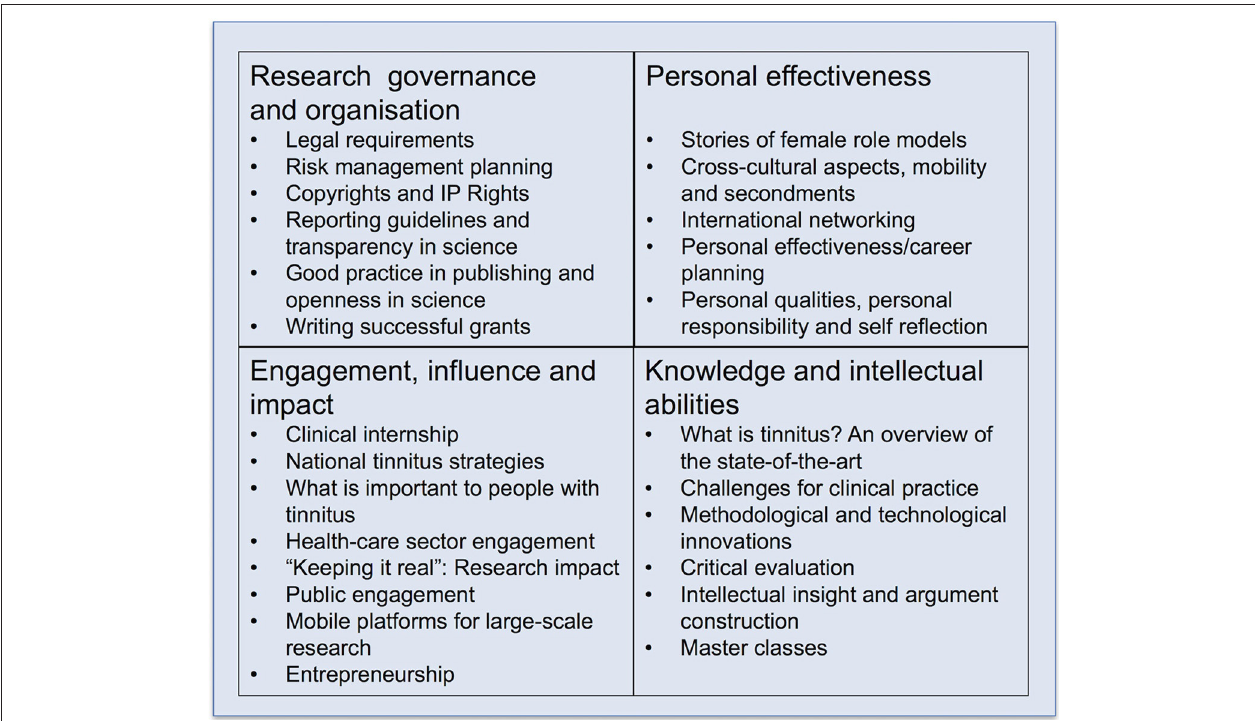
FIGURE 2 | Overview of the ESIT training curriculum structured according to the Vitae Researcher Development Framework. The four essential domains of learning and development are given in the four squares, with individual training modules arranged